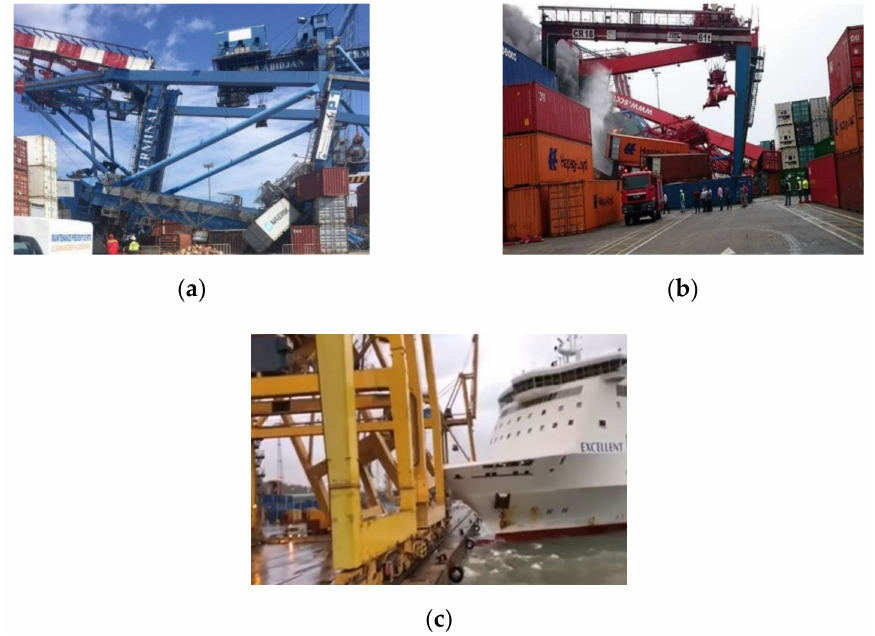
Figure 1. Berthing collisions with STS cranes of ( a ) bulk carrier; ( b ) container ship; ( c )